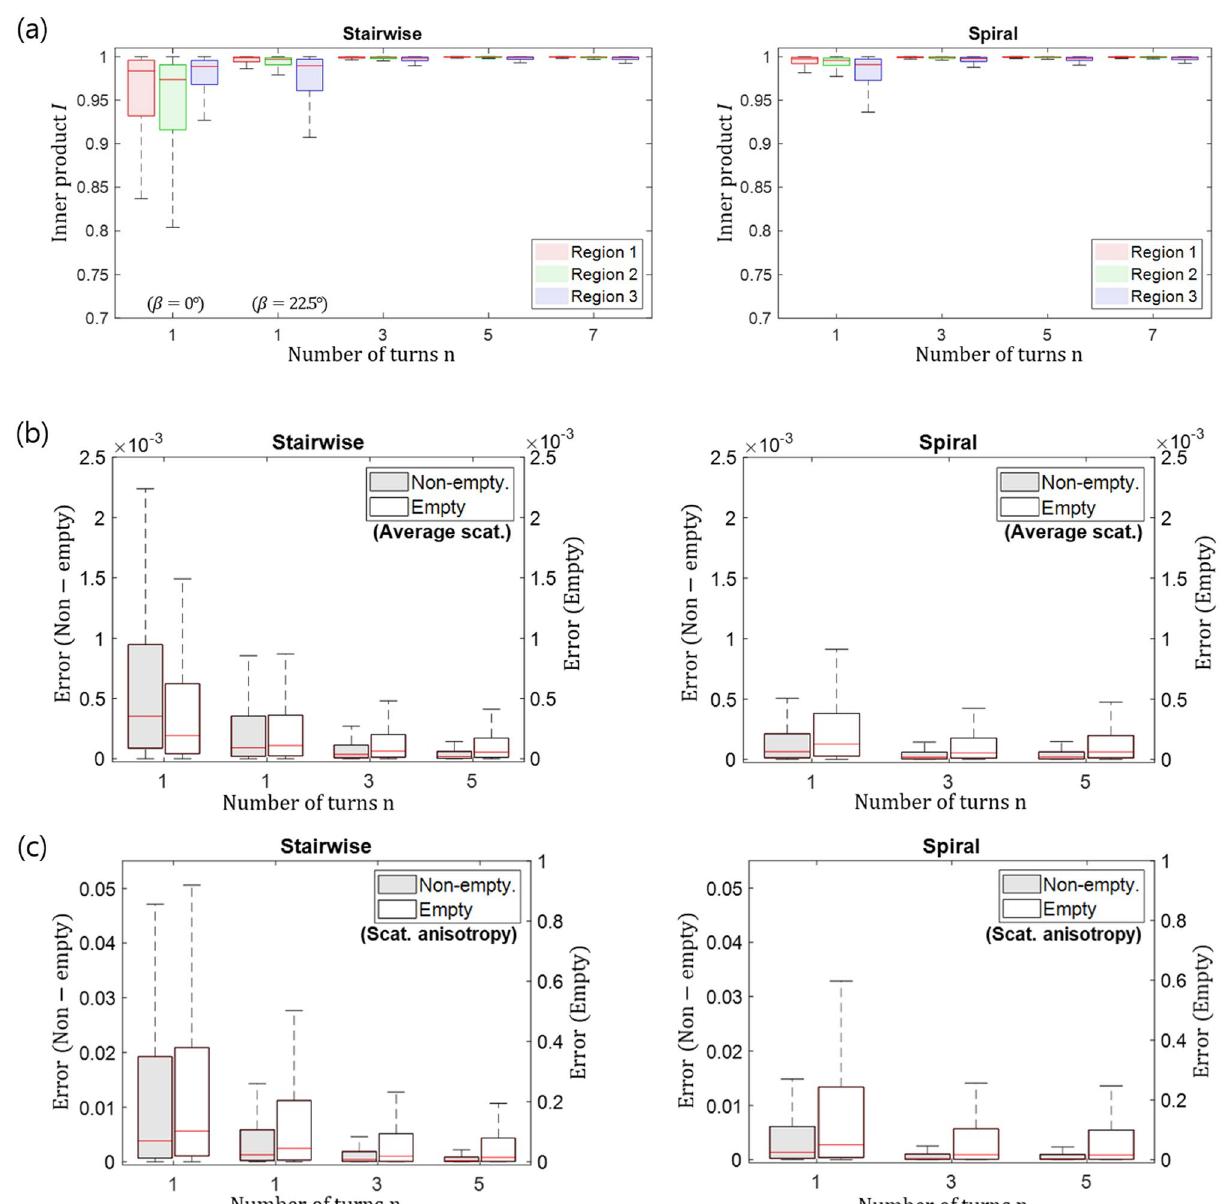
Figure 7. Quantitative assessment of the reconstruction accuracy for the validation sample. Box plots of the inner product I for the different preferential orientations are shown in ( a ). The error E of the average scattering is shown in ( b ) and of the scattering anisotropy in ( c ). Note the separate axis scales of the non-empty and the empty scalar error E . For the results evaluation (Fig. 7), voxels belonging to the 3 different regions shown in Fig. 6a have been considered. The inner product I was calculated for each region defined as the group of voxels in a box surrounding the region and the results are shown in Fig. 7a. We observe relatively more deviation from the reference with a fixed tilt angle of β = 0 ◦ compared to the other cases. Also, the deviation is larger for the region 1 and 2 where the fibres lie in the horizontal (x–y) plane. As projection views at tilt angles larger than 0 ◦ are added, the reconstruction accuracy in the x–y plane increases. For n ≥ 3 , the reconstructed orientation is already close to the reference for both the stairwise and spiral acquisition schemes. For the calculation of the error E , the reconstructed volume was subdivided in empty and non-empty regions by applying a threshold to the average scattering. The group of voxels with an average scattering signal higher than 30 % of the maximum signal over the entire reference volume was defined as the non-empty region and the group of voxels with a signal smaller than the defined threshold was defined as the empty region. For the pixels in both regions, the error E was calculated and the box plots are shown in Fig. 7b,c. In general, the error E was largest when n = 1 for the stairwise acquisition, whereas no major difference is observed for n ≥ 3 , in agreement with the analyses in the previous sections. The error E for the scattering anisotropy in the empty regions was particularly large (Fig. 7c)